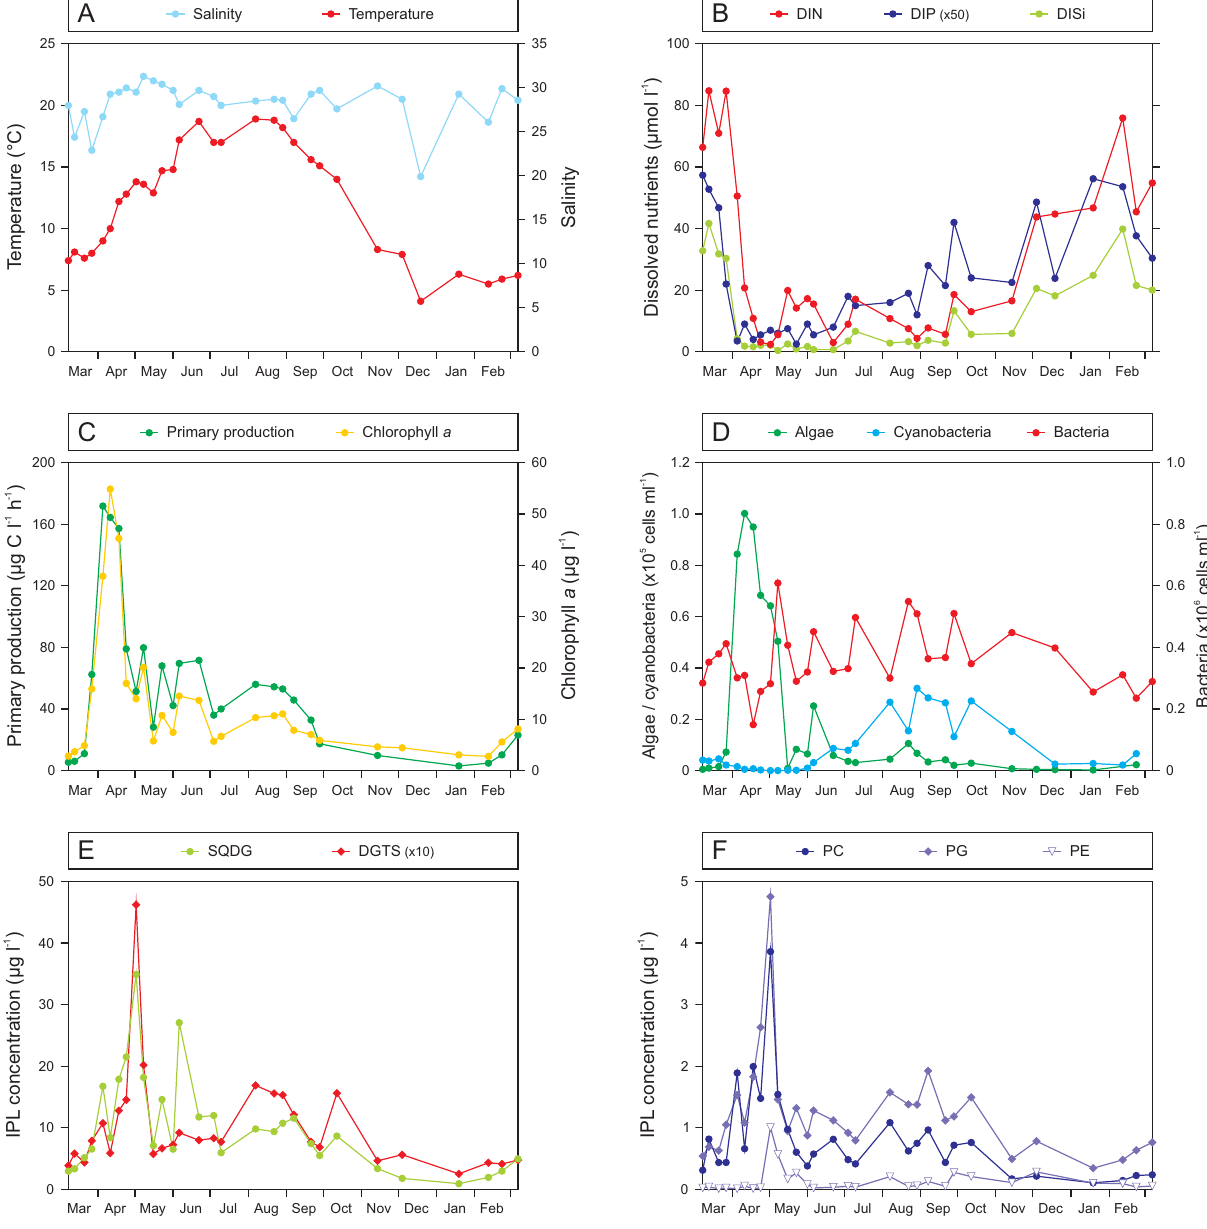
Fig. 2. Time series of: (A) salinity and temperature; (B) dissolved inorganic nutrient concentrations; (C) primary production and chlorophyll a concentrations; (D) microbial abundances; (E) and (F) intact polar lipid concentrations (see Fig. 4 for